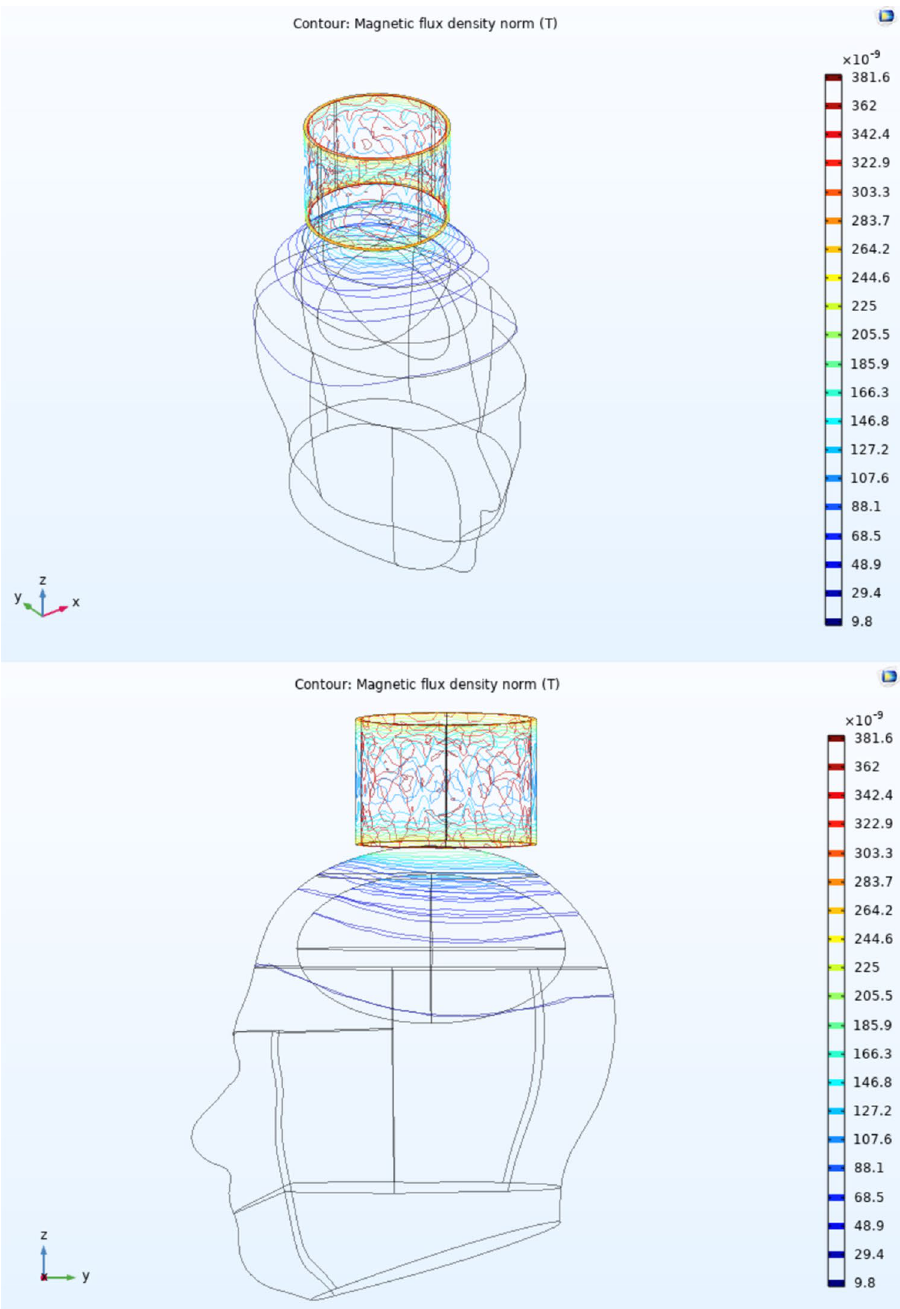
Figure 6. The 3D model of a human head with a coil sensor generated in COMSOL Multiphysics. The ellipsoid within the head is modeled as a lesion. As seen in both perspectives, the point of maximal lesion volume perpendicular to the coil, which also happens to have the closest proximity to the coil, produced the largest magnetic flux